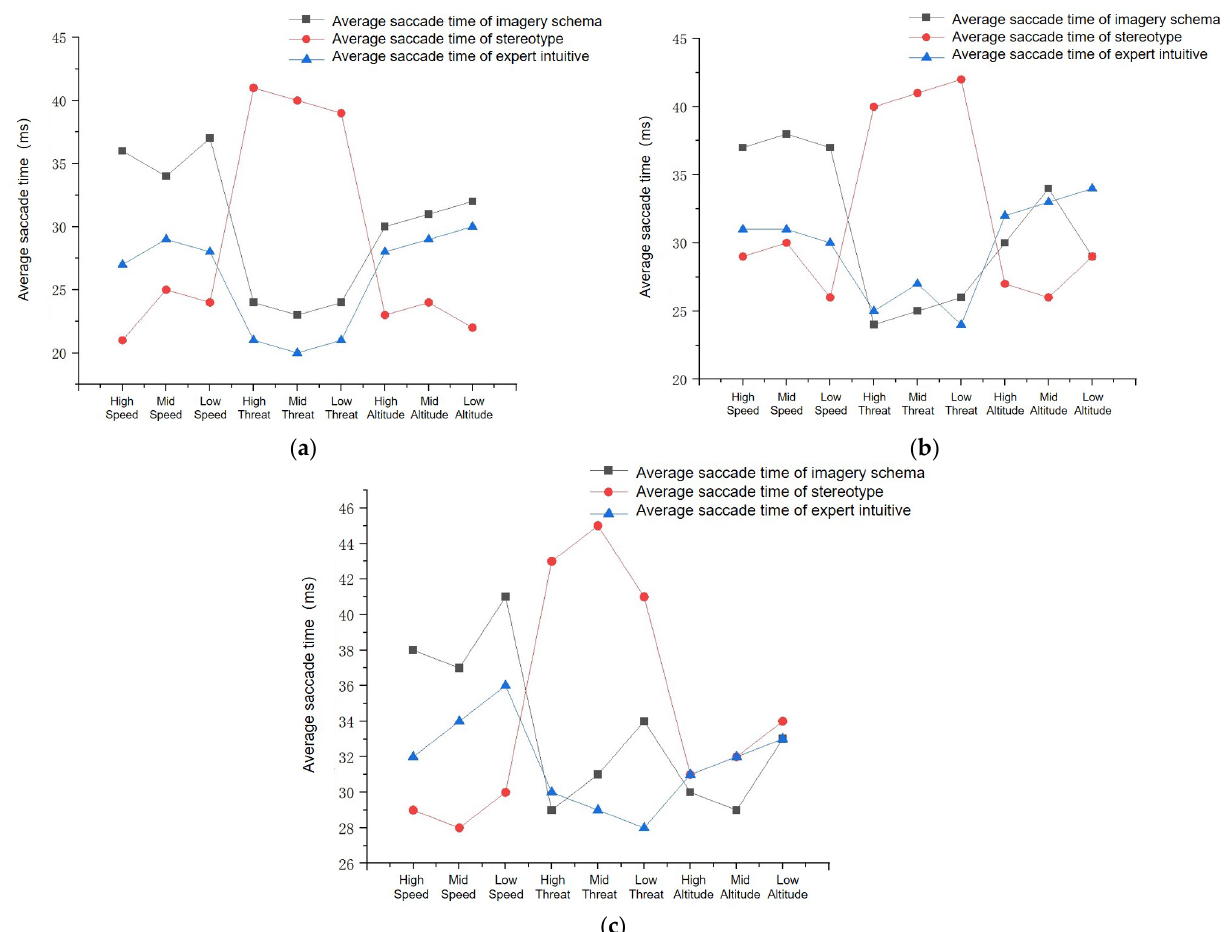
Figure 6. Average eye jump time. ( a ) 2000 ms; ( b ) 4000 ms; ( c ) 6000 ms. A comparison of the scanned path diagrams of different groups (Figure 7) revealed that the subjects’ scanned paths always passed the brightest and largest target in the diagram in each task experiment of the imagery icon group, whereas this phenomenon was not observed in the scanned path diagrams of the other groups, indicating that the high-brightness icons attracted more attention of the subjects.